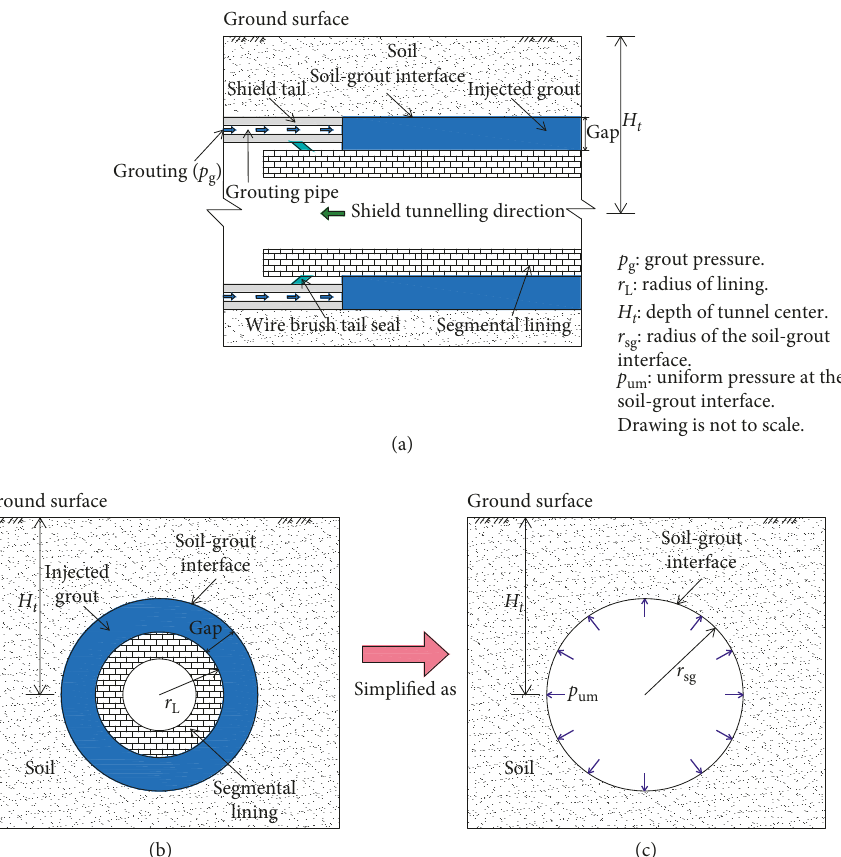
Figure 1: Schematic illustration of ground movements induced by expansion of a cylindrical cavity: (a) longitudinal and (b) transverse views of the grout injection into the annular gap surrounding; (c) expansion of a cylindrical cavity with uniform radial stress in a half-plane.